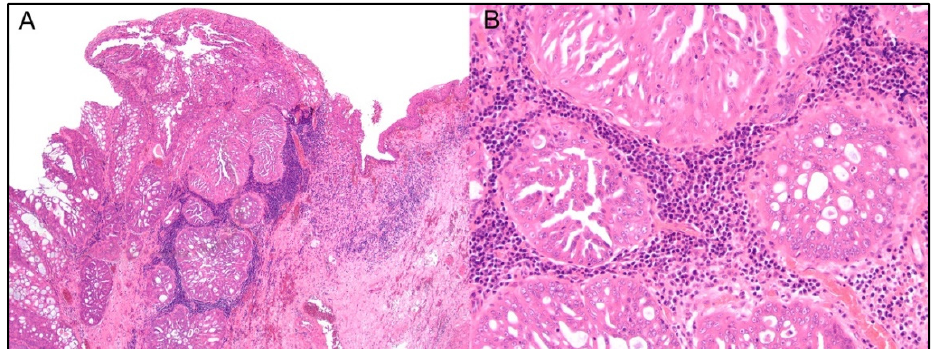
Figure 6. Canine urothelial cell carcinoma , hematoxylin, and eosin, urothelial cell carcinoma. ( A ) Moderate numbers of lymphocytes are multifocally present within the fibrovascular stroma adjacent to the neoplastic proliferative front, 4×. ( B ) Focally extensive increase in numbers of plasma cells (tumor infiltrating plasma cells, TIPs) surround cancer nests, 20×.